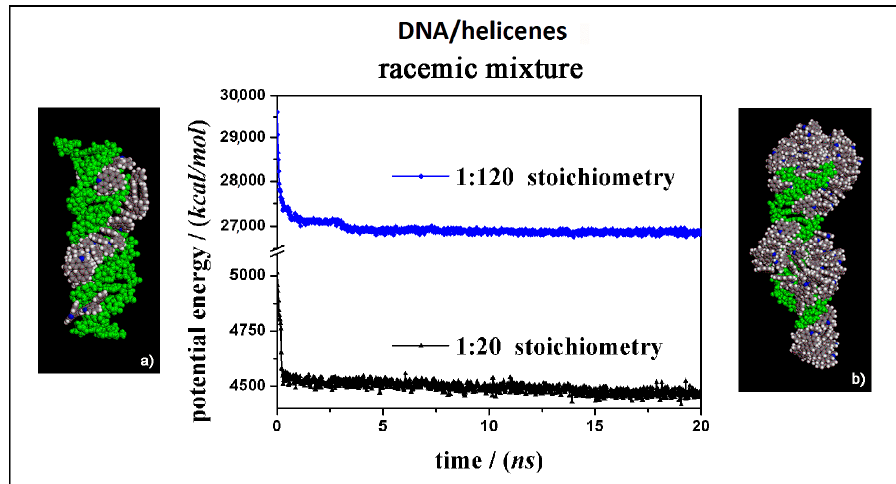
Figure 8. Solvent-accessible surface area colored by the atom charge for the optimized geometries of Figure 9. Optimized geometries of ( M )-HA and ( P )-HA in a racemic mixtures at low concentration on the left ( a ) and at high concentration on the right ( b ) after energy minimization of the conformation double-stranded DNA as data from Protein Data Bank on the left ( a ), of the ( M )-HA ( b ) and ( P )-HA on assumed by the system at the end of the MD run considering racemic mixtures in 1:20 and 1:120 the right ( c ) after energy minimization of the conformation assumed by the system at the end of the stoichiometry respectively. In the central panel the potential energy calculated during MD run lasting MD run considering enantiopure compounds in a 1:120 stoichiometry. The color code is the same as in 20 ns for racemic mixture in 1:20 stoichiometry (black symbols) and in 1:120 stoichiometry (blue Figure symbols) respectively. The color code is the same as in Figure 5.